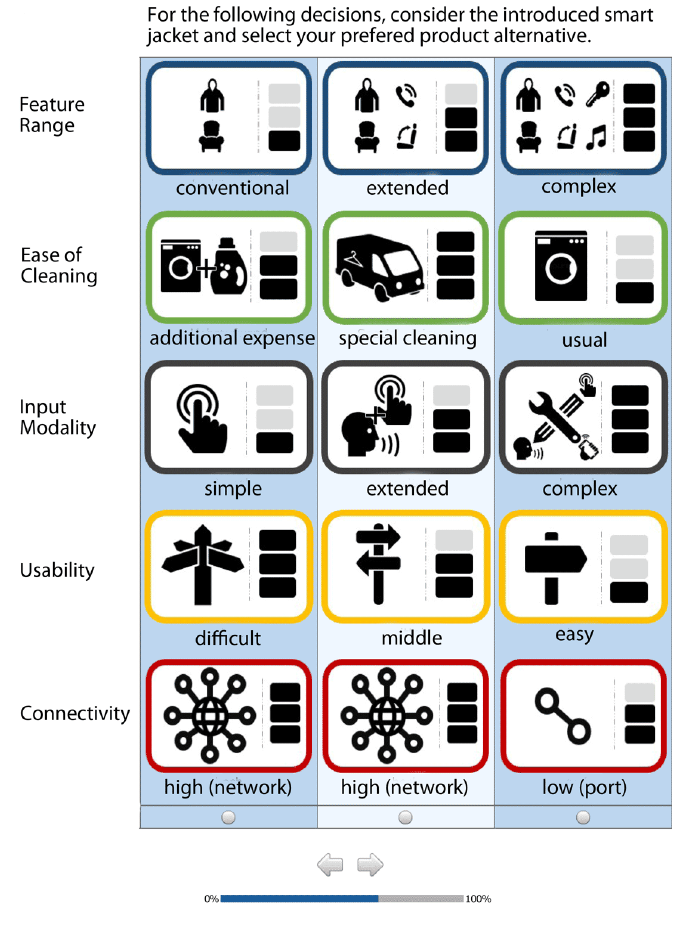
Figure A1. Exemplary choice task of the conjoint analysis for the smart